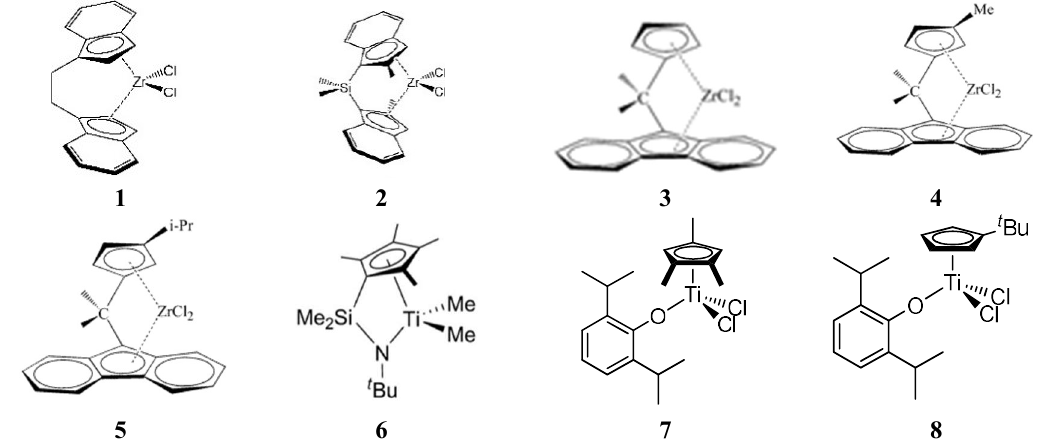
Figure 1. Structures of the metallocenes and half-metallocenes used for copolymerization reported.